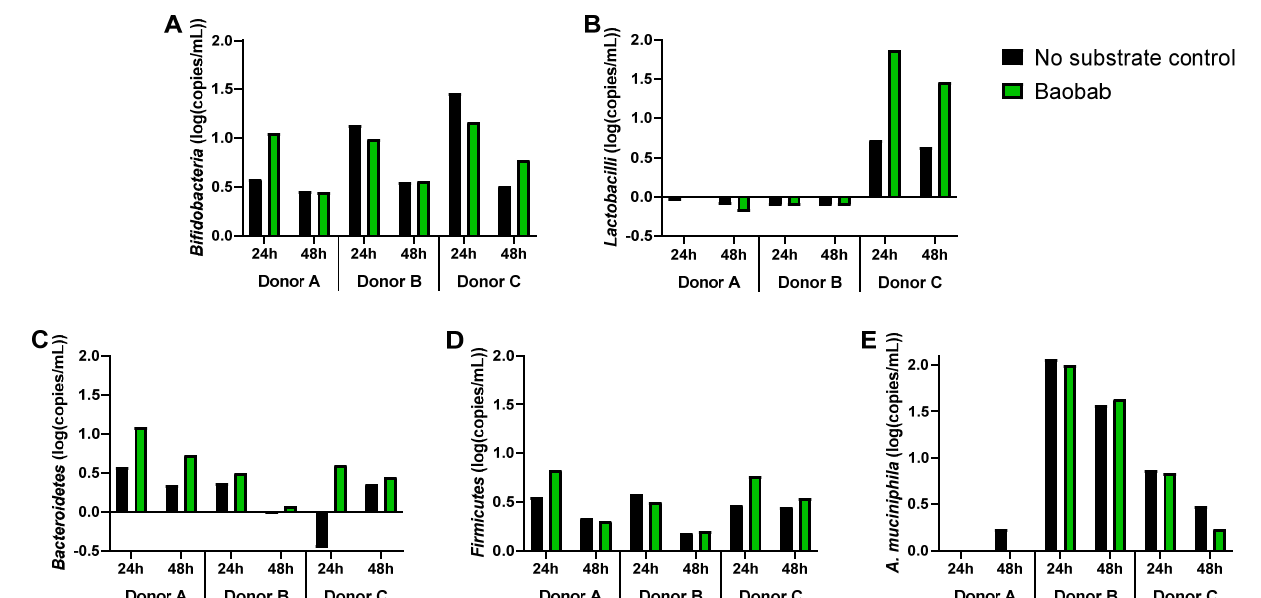
Figure 6. Effect of baobab fruit pulp powder on five specific taxonomic groups during 48 h incubations as determined through qPCR. Changes in absolute abundances (log (16 S rRNA gene copies/mL)) of Bifidobacteria ( A ), Lactobacilli ( B ), Bacteroidetes ( C ), Firmicutes ( D ), and Akkermansia muciniphila ( E ) after 24 h and 48 h of incubation as compared to 0 h upon dosing of baobab fruit pulp powder (green) versus a ‘no substrate control’ (black) for three healthy adults (donor A, donor B, donor C) ( n =